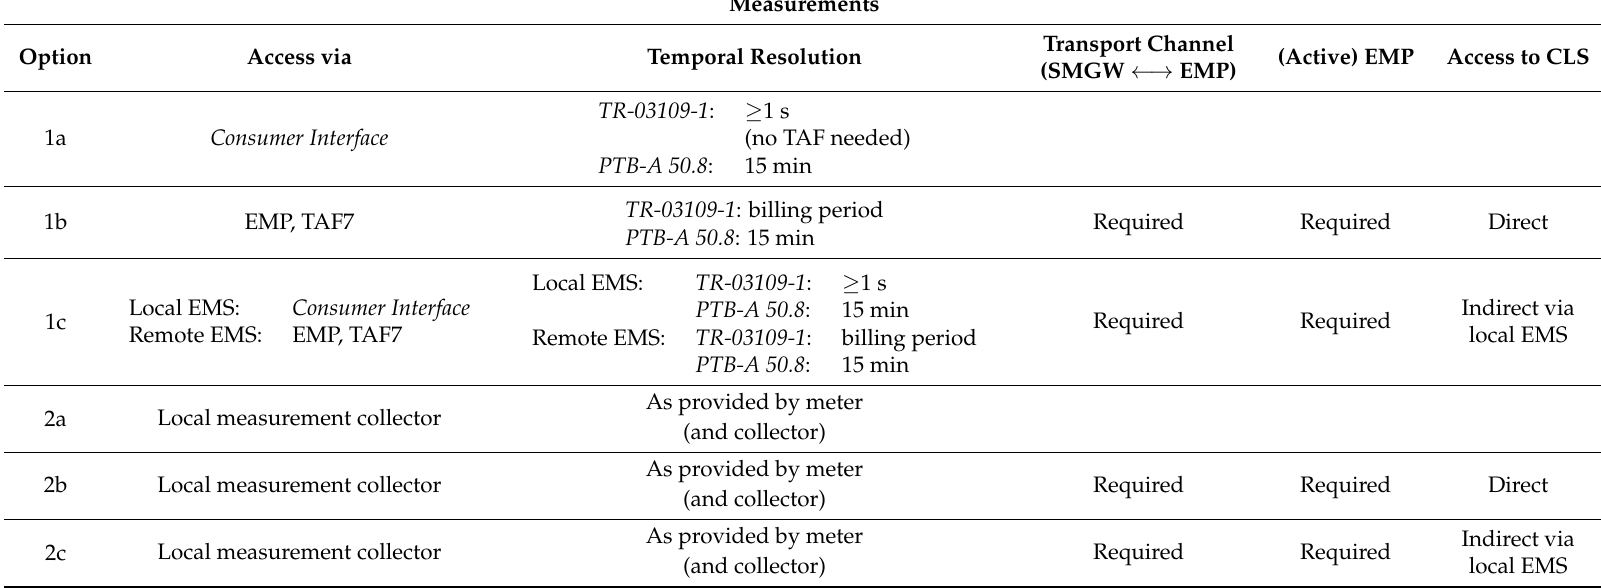
Table 2. A summary of all presented options for integrating EMSs into Smart Metering Systems . In the case of billing-relevant data, the temporal resolution will be 15 min for electricity and 60 min for gas. This is unsuitable for many energy management use cases that require more fine-grained measurements. When the data are not used for billing, the PTB-A 50.8 requirements are not applicable and the TR-03109-1 requirements define the theoretical constraints. The BSI technical guideline indirectly states that billing periods of 5 min or less must be supported. In this case, for Option 1a , the maximum resolution is likely to be determined by the meter. All options that require an EMP do require an active EMP. For Option 1c , it is important to note that some SMGWs separate the HAN and CLS functionally, i.e., the EMS needs to be connected to both hardware ports, HAN and CLS, to simultaneously access the Consumer Interface and use the transparent data